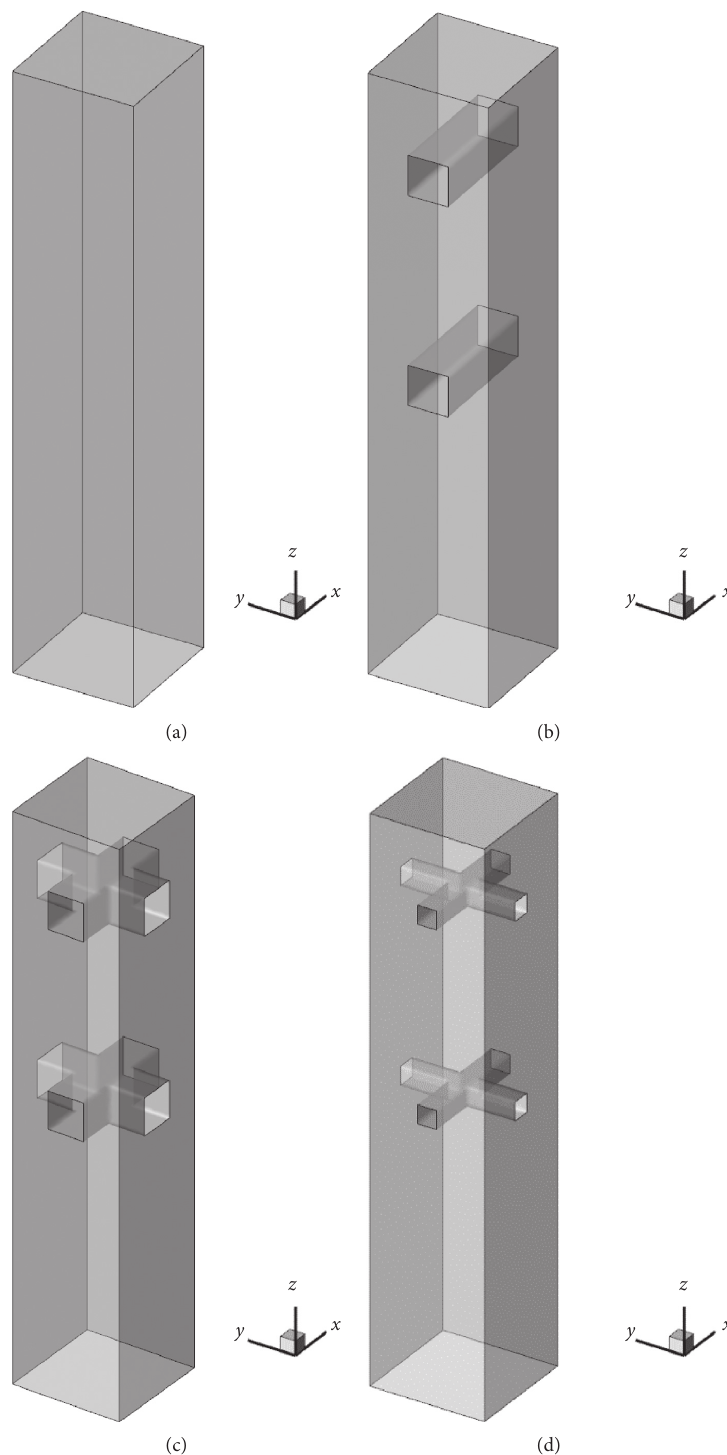
Figure 1: Four kinds of numerical simulation models with openings. (a) L-1. (b) L-2. (c) L-3. (d) and creates a stagnation point at about 2/3 height of model. 2.2.2. Flow Field at Different Elevations. Figure 8 shows the The maximum positive pressure is emerged near the stag- mean wind pressure contour distributions on windward and nation point. After the openings are set, the flow at the leeward faces at different elevations for L-1 model, L-2 opening position is introduced into the leeward face, and the model, and L-3 model under wind direction of 0 ° , respec- positive pressure near the opening is decreased. The single tively. For L-1 model, the wind flow strikes the windward